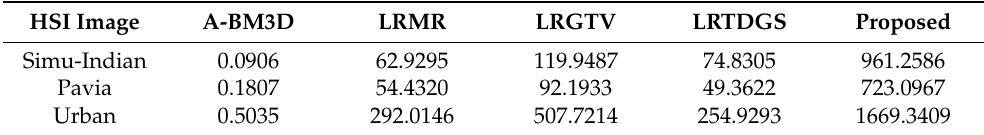
Table 4. Computational times of different methods (unit: s).